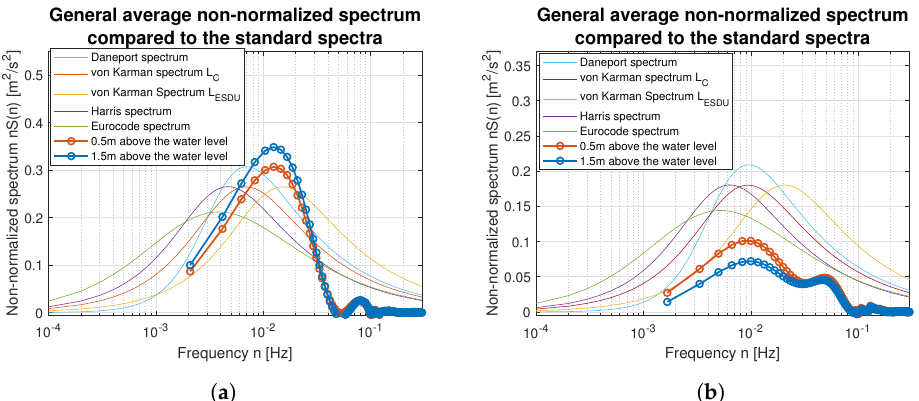
Figure 18. Estimated spectra compared to standard ones: ( a ) Strong wind (8 BFT in ship scale); ( b ) Strong wind (10 BFT in ship scale). Simple comparison of curves plotted in Figures 17 and 18 allow us to point the standard spectrum closest to the estimated from lake measurements for each of the analyzed cases. They are plotted separately in Figures 19–24.